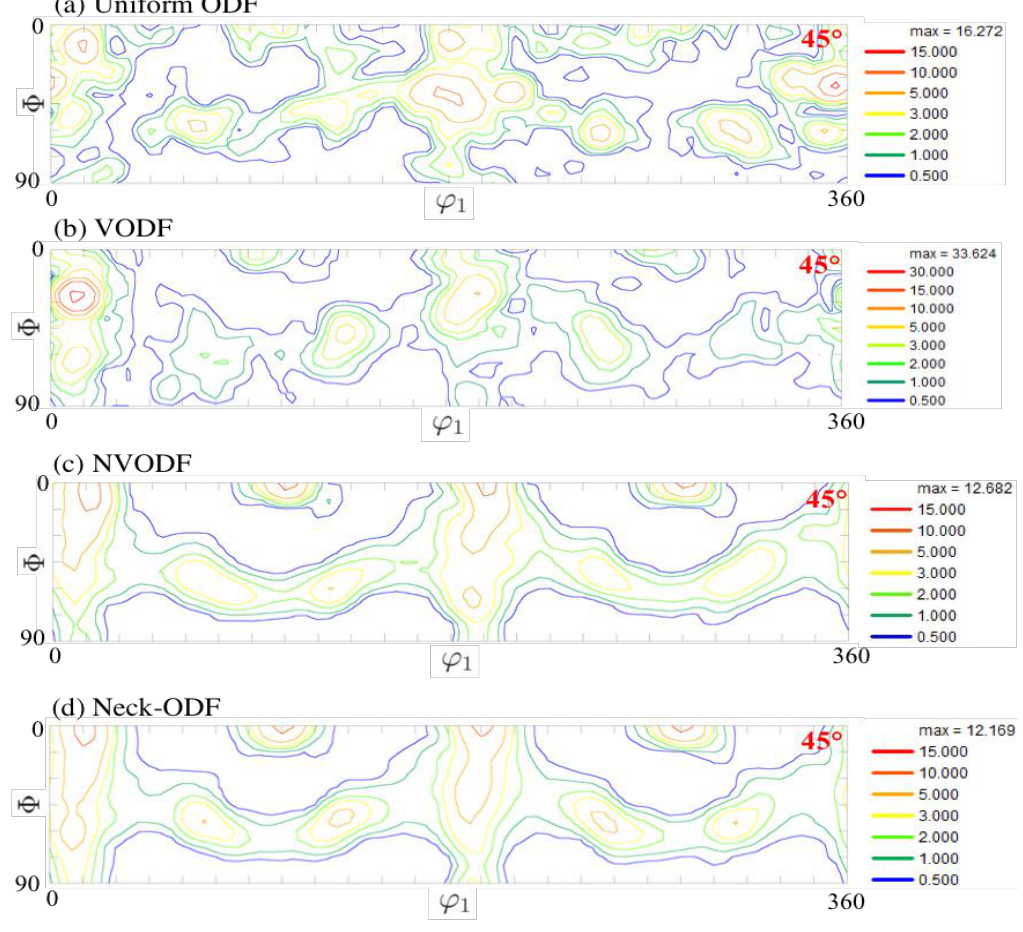
Figure 8. ϕ 2 = 45 ◦ section of ODFs of the steel at two various deformation levels; ( a ) uniform deformation union ODF (UODF) (calculated from 796,000 data points), ( b ) post uniform VODF (131,000 data points), ( c ) post uniform no-void-ODF (NVODF) (460,000 data points), and ( d ) necking or post uniform ODF consist of the merged ODFs in b and c .